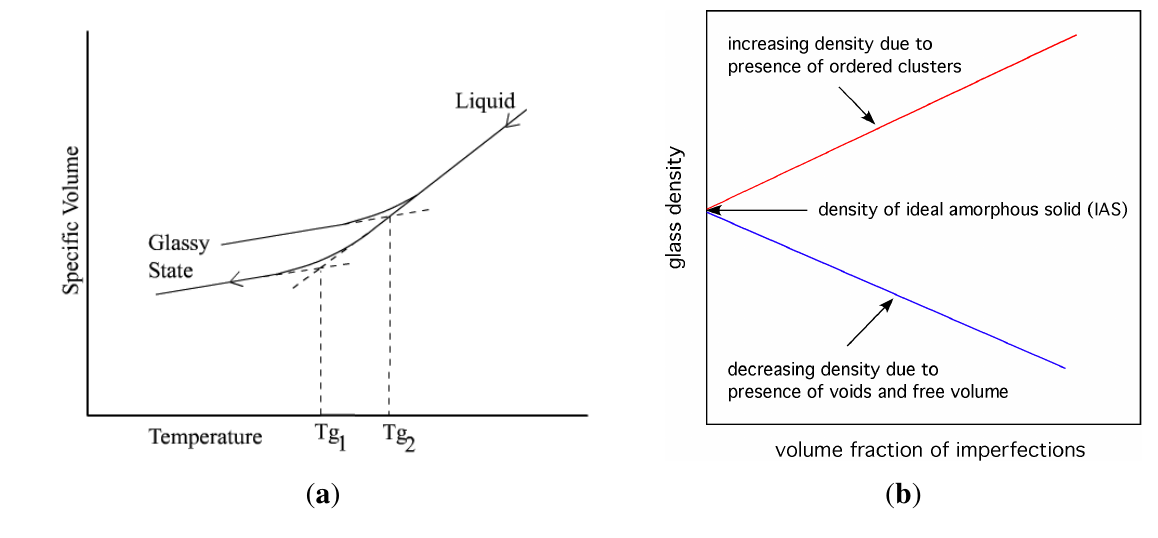
Figure 10. On the left, variation of volume with temperature for a glassy system; different glass transition temperatures for different content of imperfections. On the right, schematic representation of the effect that imperfections have on the density of